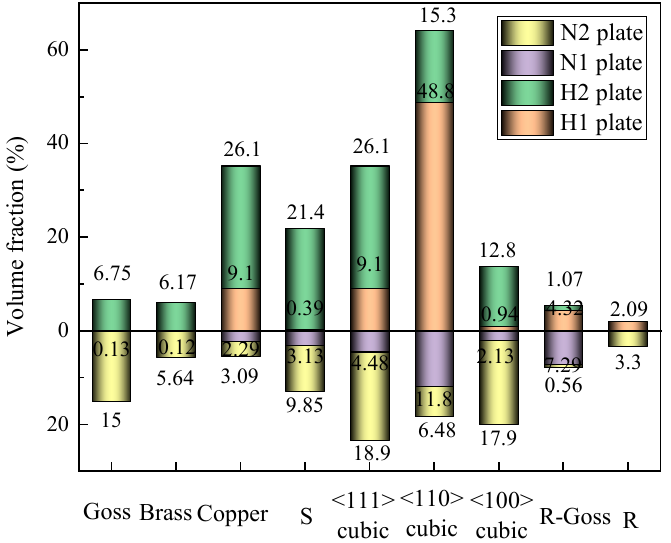
Figure 10. Volume fraction of the main texture components of annealed 1561 aluminum alloys in the central region.